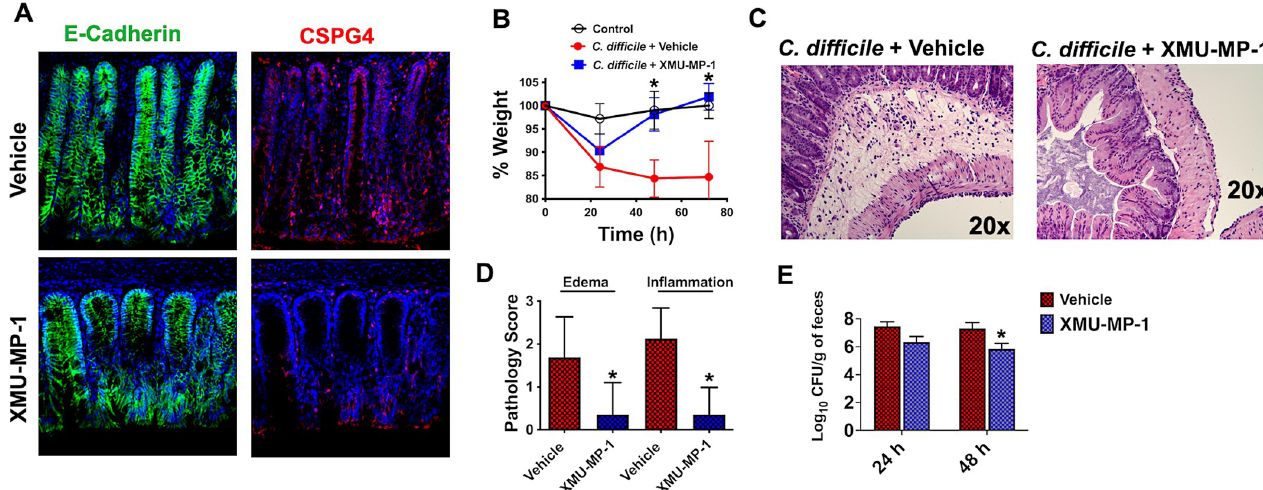
Fig 5. Amelioration of C . difficile disease in mice treated with XMU-MP-1. Mice were administered intraperitoneal injections of XMU-MP-1 (1 mg/kg) or vehicle daily for two days prior to oral gavage of 10 6 C . difficile spores. XMU-MP-1 was administered daily following infection for a total of 5 injections during the course of the experiment. (A) Immunofluorescence staining of colon excised from mice 24 h after the last injection with XMU-MP-1 or vehicle. (B) Percent change in weight in mice post infection presented as mean (n = 6) ± S.D. (C) Representative H&E images of mouse ceca at 96 h post infection. (D) Pathology scores of mouse ceca at 96 h post infection for vehicle (n = 16) ± S.D and XMU-MP-1 (n = 14) ± S.D. (E) Levels of C . difficile in the fecal pellets from mice infected with C . difficile with and without exposure to XMU-MP-1. * p < 0.05 indicates significance between vehicle and XMU-MP-1 treatment as determined by Student’s